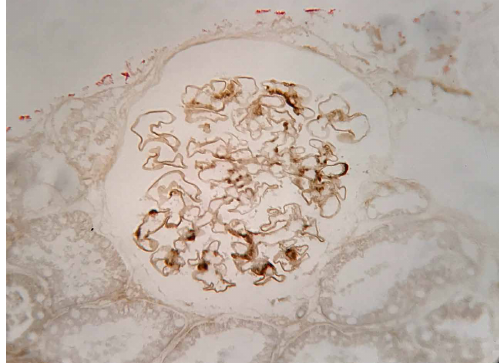
Figure 3: Mesangial IgA deposition was observed by immunohistochemistry.